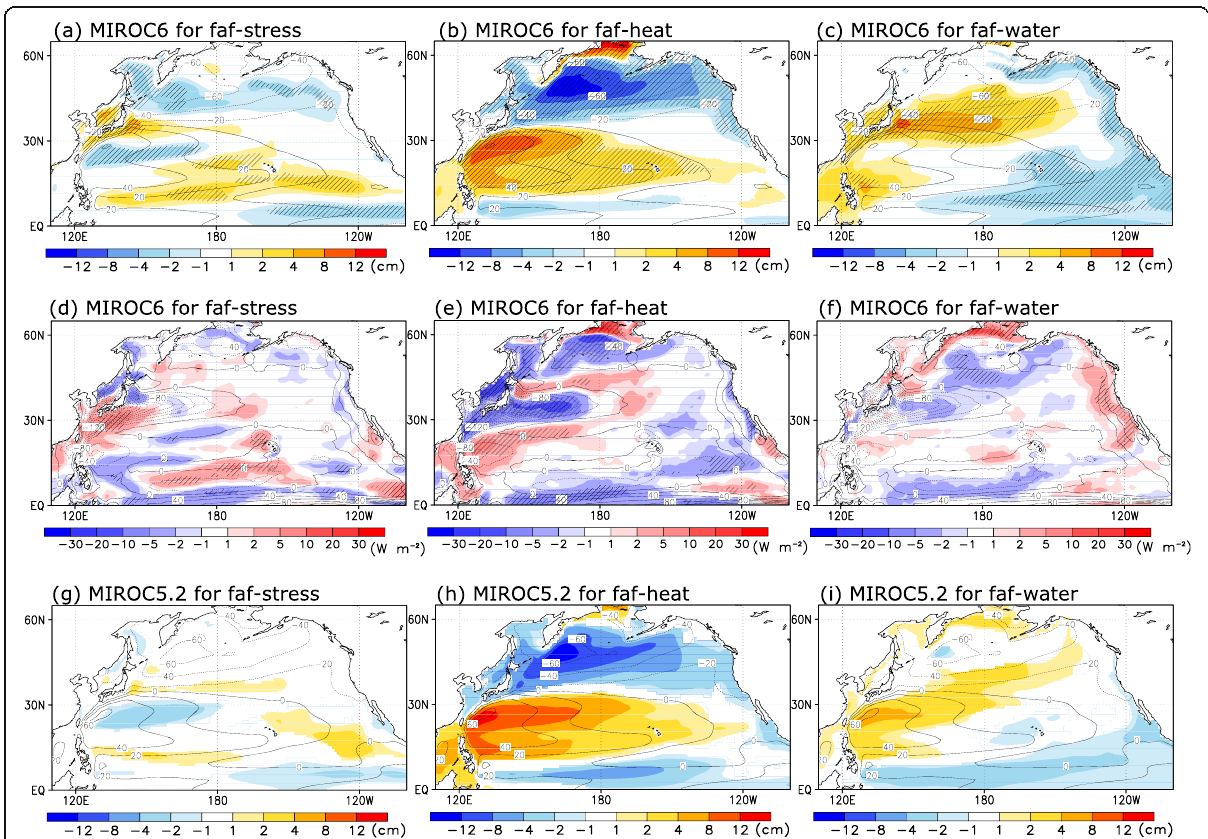
Fig. 2 Dynamic sea level changes (cm) for years 51 – 70 relative to piControl for a faf-stress, b faf-heat, and c faf-stress experiments of MIROC6. The contours in the upper panels indicate the climatological dynamic sea level in piControl. Regions with signals at a 90% confidence level are hatched. The middle panels show the heat flux change Δ Q SST (Wm − 2 ) for years 1 – 70 relative to piControl for d faf-stress, e faf-heat, and f faf- stress experiments of MIROC6. The contour indicates the climatological net heat flux into the ocean in piControl. The lower panels ( g – i ) are same as the upper panels, but for the ensemble mean of three members of MIROC5.2. Areas in which the signs of the three members do not agree were masked